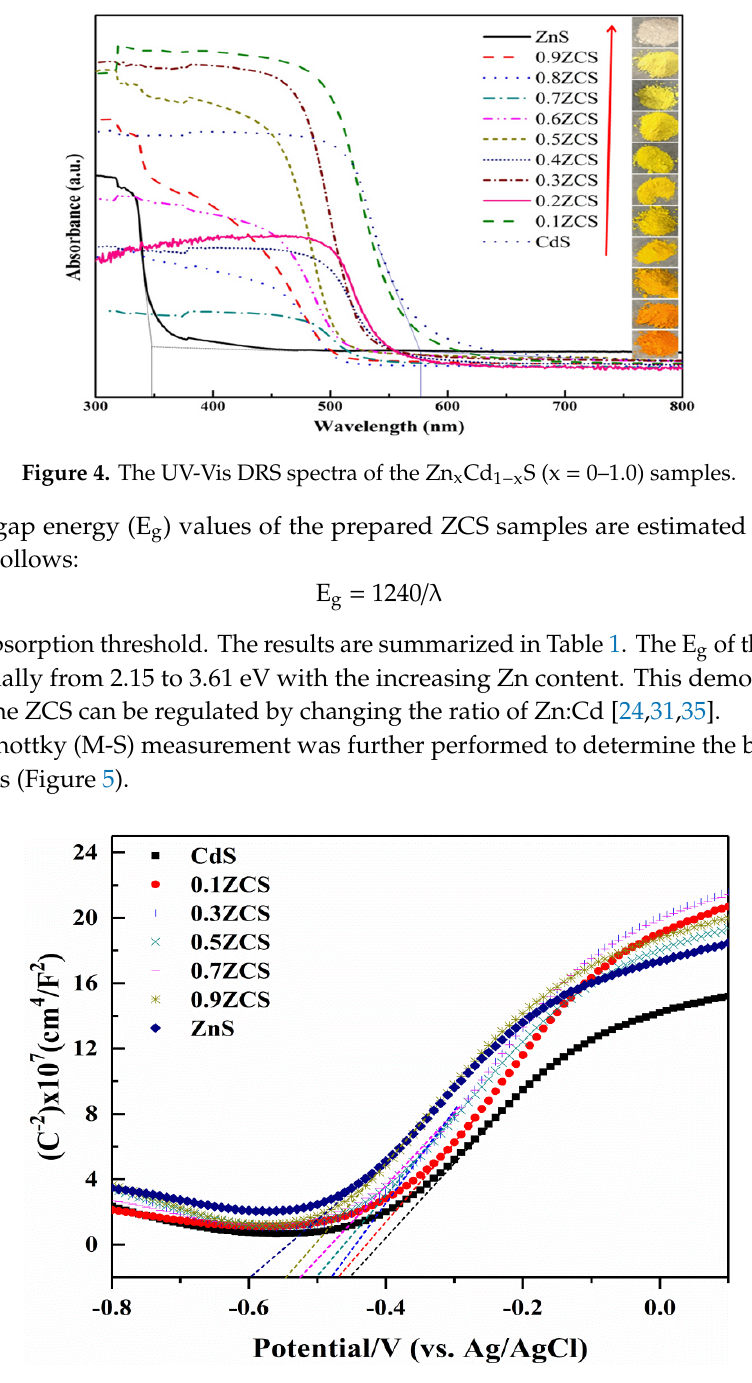
Figure 5. Mott–Schottky plots of the prepared ZCS samples as electrode materials.